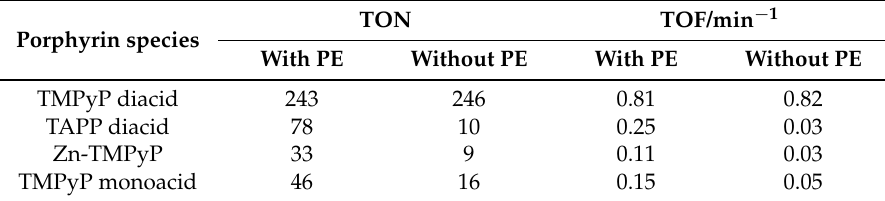
Scheme 3. Reaction scheme of the investigated model reaction.